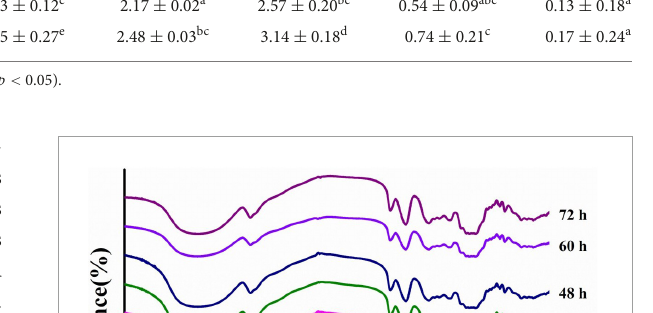
Differentlowercaselettersrepresentstatisticallysignificantdifferencesamongsamples( p < 0.05).